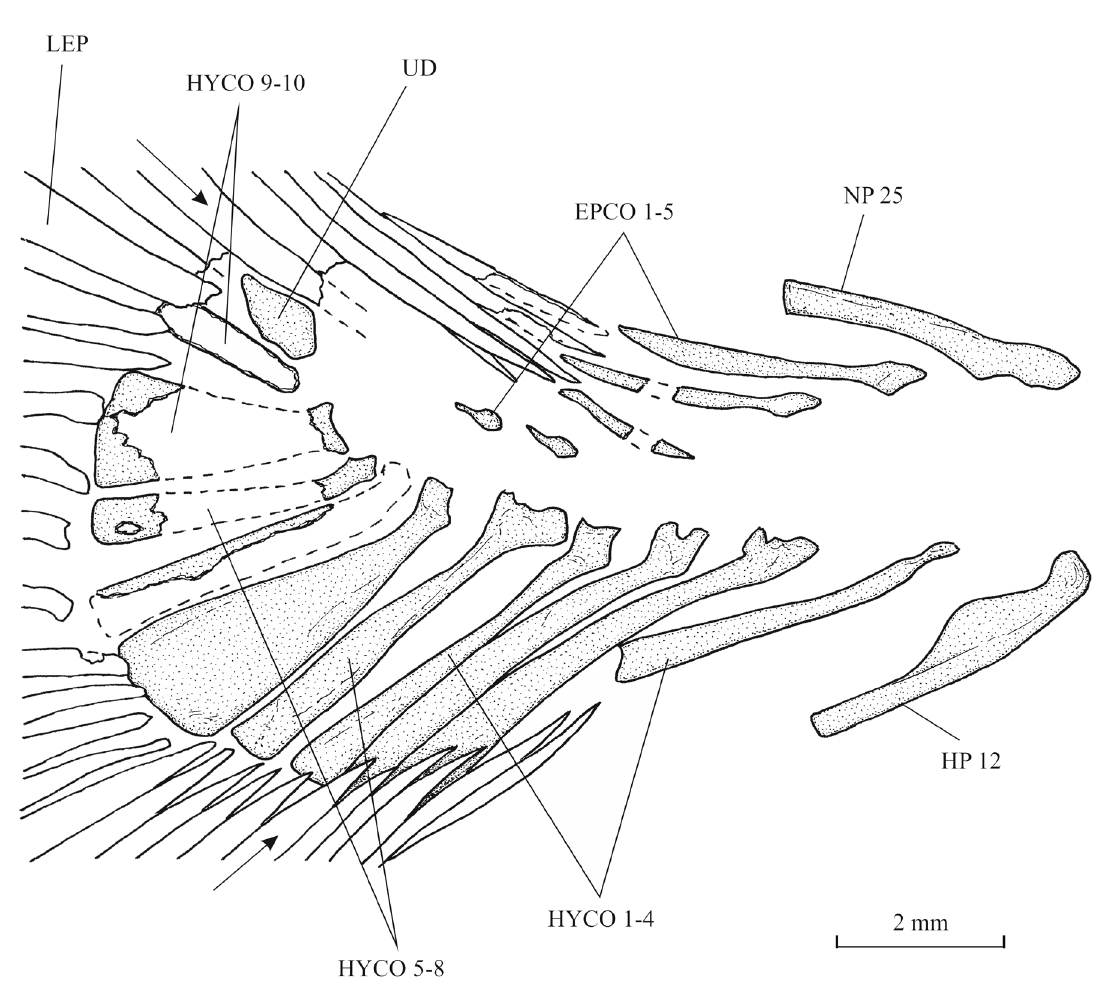
Fig. 9. Libanopycnodus wenzi gen. et sp. nov., holotype, caudal skeleton (CLC S-574). The arrows point to the two most external principal caudal rays.